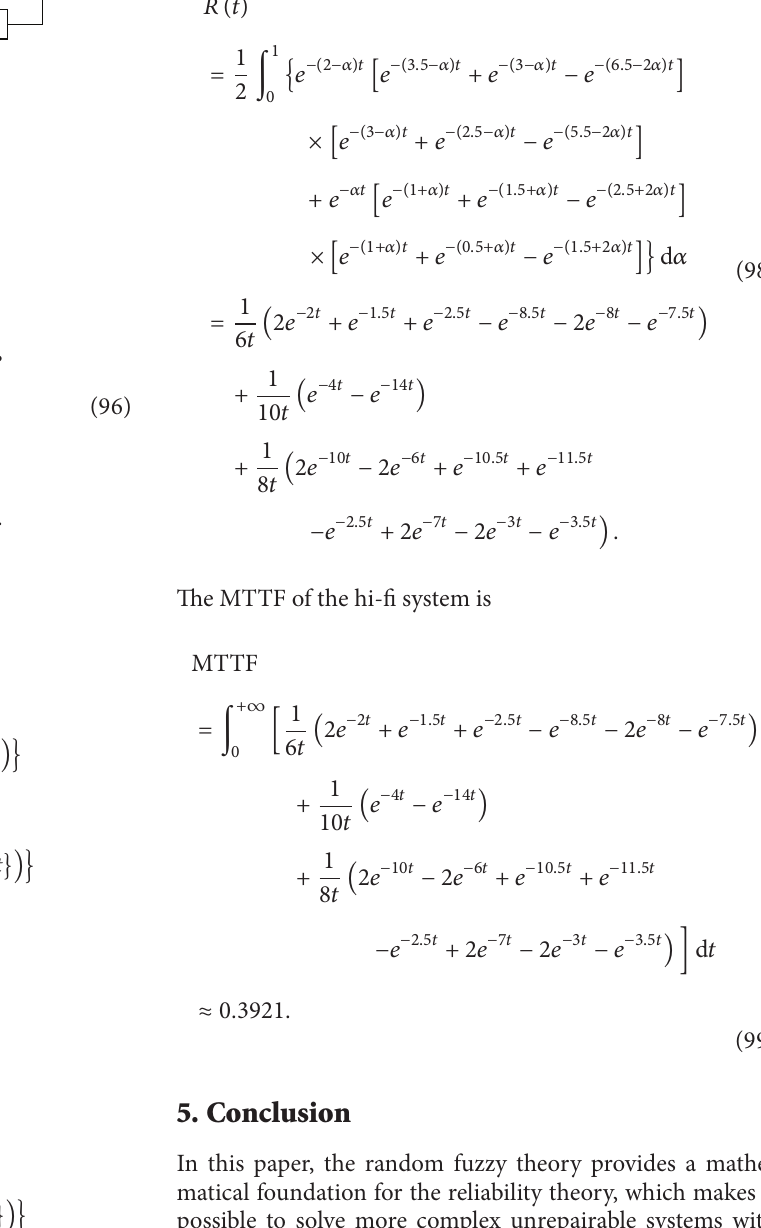
Figure 2: A hi-fi